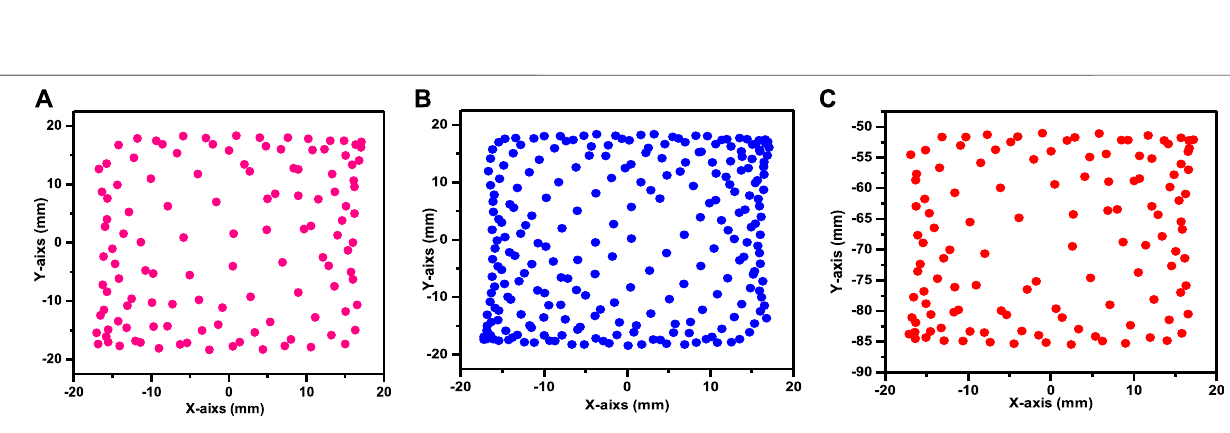
Frontiers in Physics |